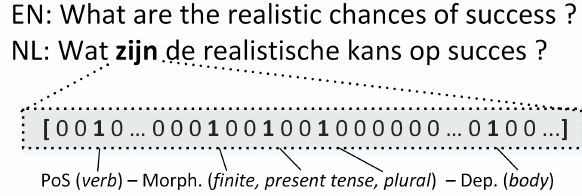
Figure 6. Binary vector for zijn (are) consisting of 1s for its PoS, morphology and dependency features and 0s for the remaining items in the vocabulary.